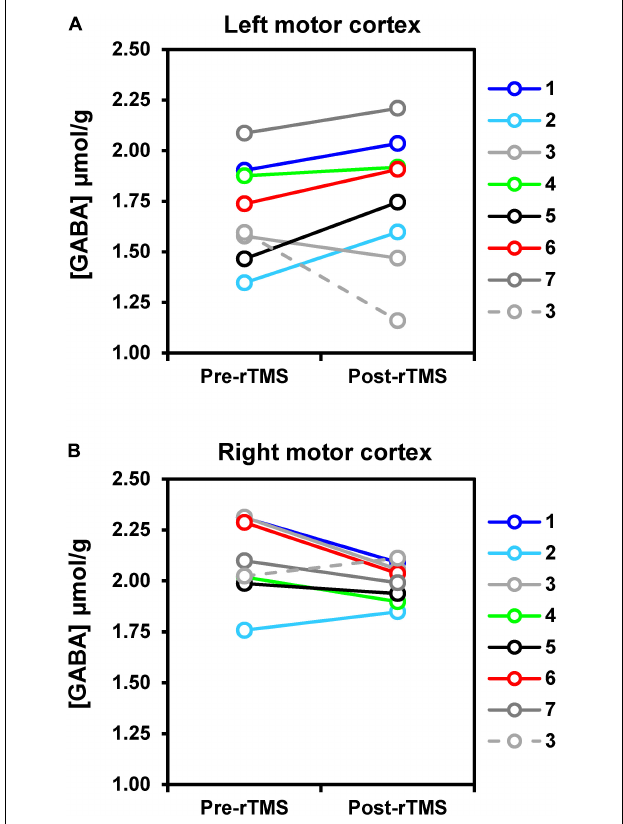
FIGURE 4 | rTMS-induced changes of GABA concentrations in left (A) and right (B) motor cortices. Solid lines represent data obtained with 1-Hz rTMS intervention ( N = 7), while the dashed line refers to the one subject (namely subj. 3) who received 5-Hz rTMS in a separate study visit. Changes in GABA levels were small but detectable with statistical significance at uncorrected p -value. In particular, GABA increased by 8% on average after rTMS as compared to pre-rTMS in the motor cortex ipsilateral to the stimulation ( p = 0.043), whereas it decreased by 6% on average in the right motor cortex ( p =